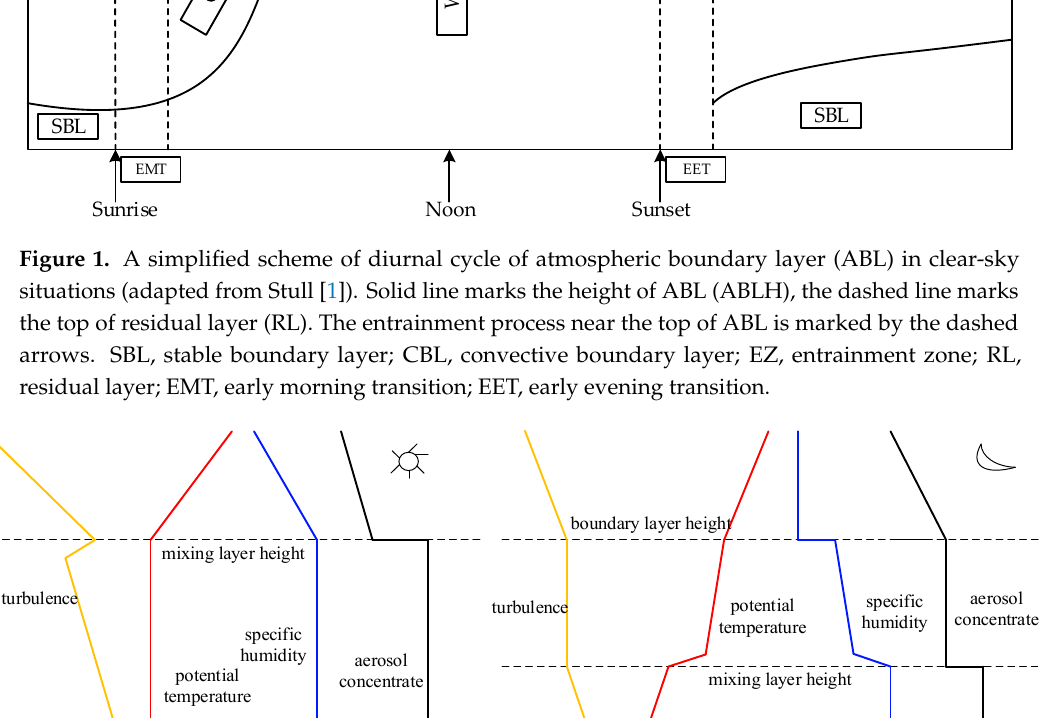
Figure 2. Principle vertical profiles of some variables for the well mixed boundary layer during daytime ( left ), and the more stable nocturnal boundary layer with shallow surface mixing layer, residual aerosol layer and the above free atmosphere layer ( right ) (adapted from Stull [1]).